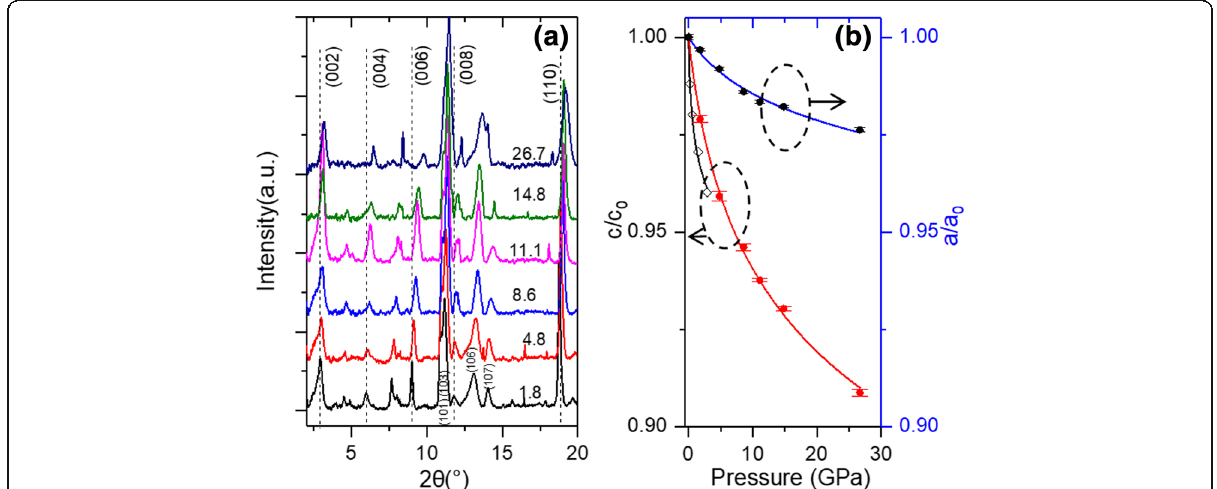
Fig. 2 a XRD spectra of Ti 3 C 2 T x at different loaded pressures. Note that the unit is GPa for the pressure annotated on each spectrum. Peaks are assigned according to ref. [26]; b experimental (dots) and calculated compressive ratio (solid line) along c and a directions. The solid lines are the fitted results using the equation r ð P Þ = r 0 ¼ ½ð δ 0 = δ 0 Þ P þ 1 (cid:2) δ